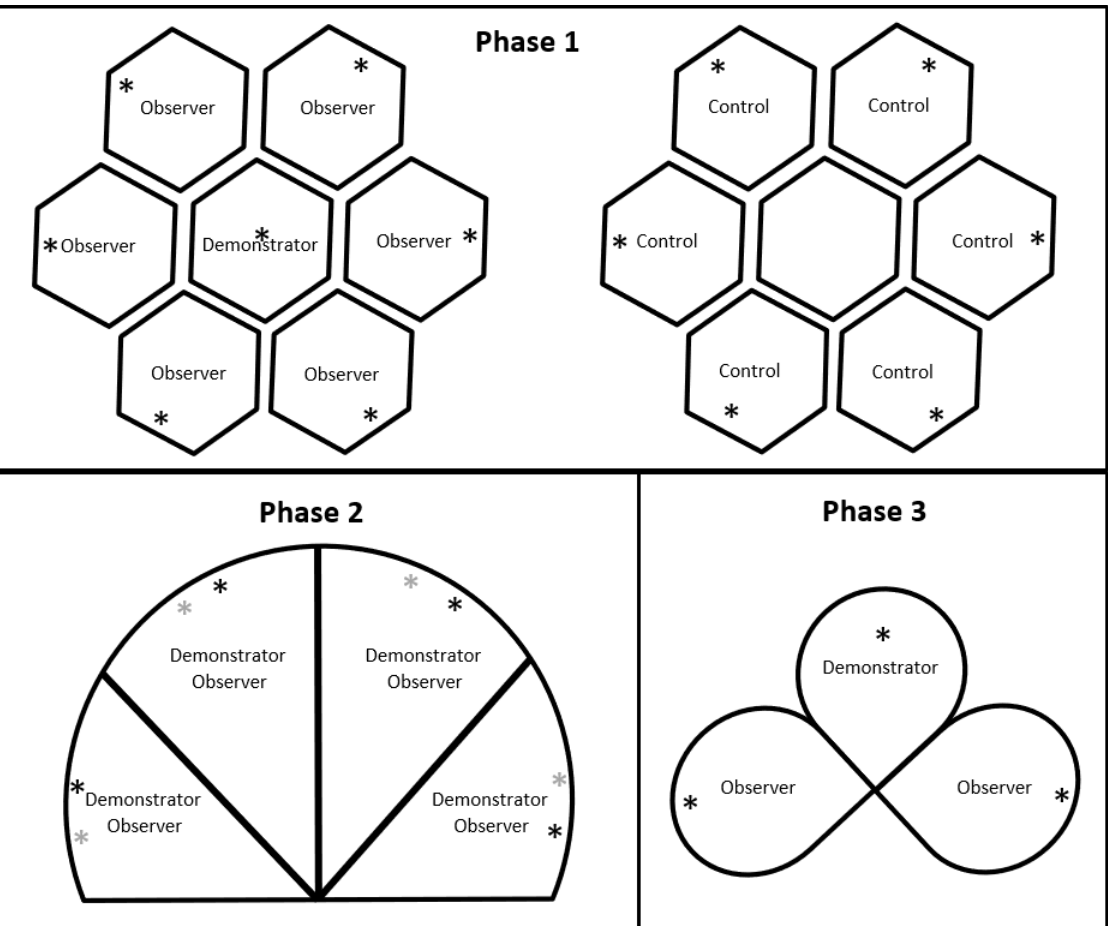
Diagrams of enclosures housing captive coyotes during Experiments 1, 2, and